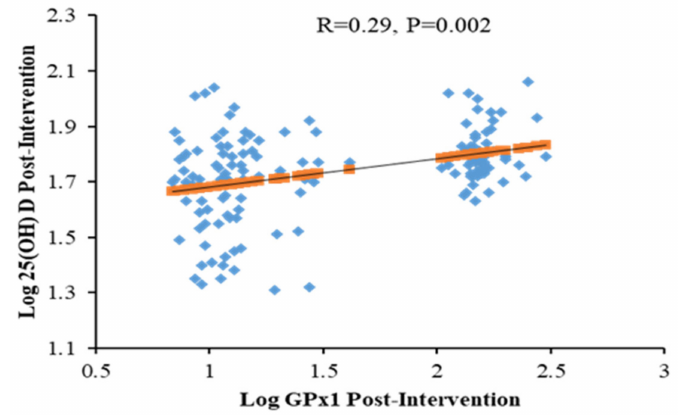
Figure 2. Relationship between Log 25(OH) D and GPx1 in all participants